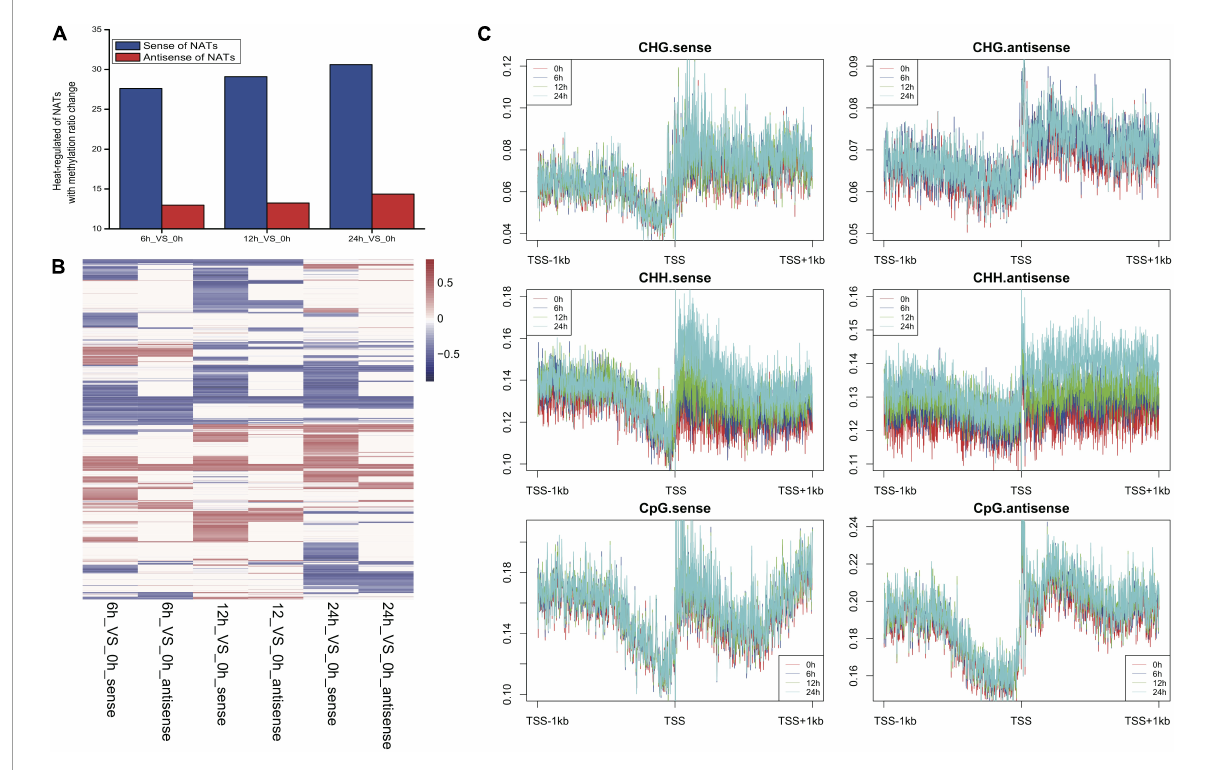
FIGURE6 Methylation associated with NAT genes. (A) Degree of methylation associated with heat-regulated NAT genes. (B) Heatmap of percentage of methylation of NAT genes at different time points. (C) The degree of different methylation types around transcription start sites (TSS) of NAT